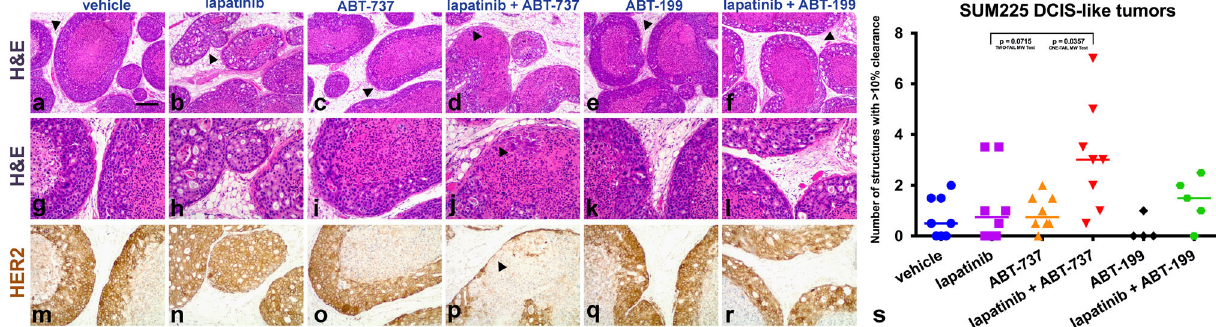
Fig. 3 Inhibition of BCL-2/XL in combination with lapatinib treatment eliminates a subset of the niche-localized tumor cells. Representative H&E low magni fi cation ( a – f ) and high magni fi cation ( g – l ) images are presented to compare treatment groups. Serial sections were subjected to HER2 IHC in order to visualize tumor cells. The matched HER2 stains are presented alongside the H&E stained sections ( m – r ). Arrowheads ( a – f ) highlight regions presented in g - l . Note multiple viable HER2+ tumor cells ( g – i , k ). Note complete elimination of HER2+ tumor cells ( j , arrowhead ) in response to lapatinib plus ABT-737 (dual BCL-2/XL inhibitor). Lapatinib plus ABT-199 (BCL2-selective inhibitor) treatment did not cause elimination of niche-localized cell populations ( l ). Graph ( s ) shows the percent loss of the outer niche-localized cells (clearance, quanti fi ed as described in the Methods) in multiple tumors from two independent experiments (Mann – Whitney test lapatinib vs. lapatinib + ABT-737; p value = 0.0357 one-tail and p value = 0.0715 two-tail). Each line represents the median. Scale bar, ~200 μ